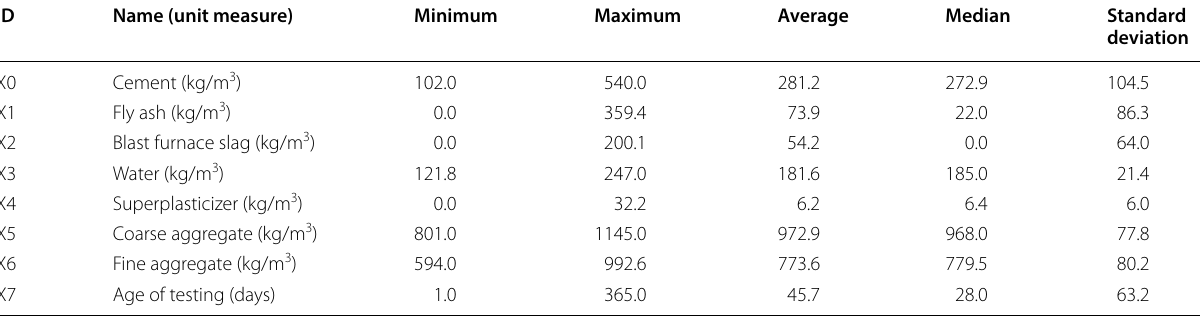
For each variable minimum, maximum, a kg/m 3 average, median and standard deviation values are reported.